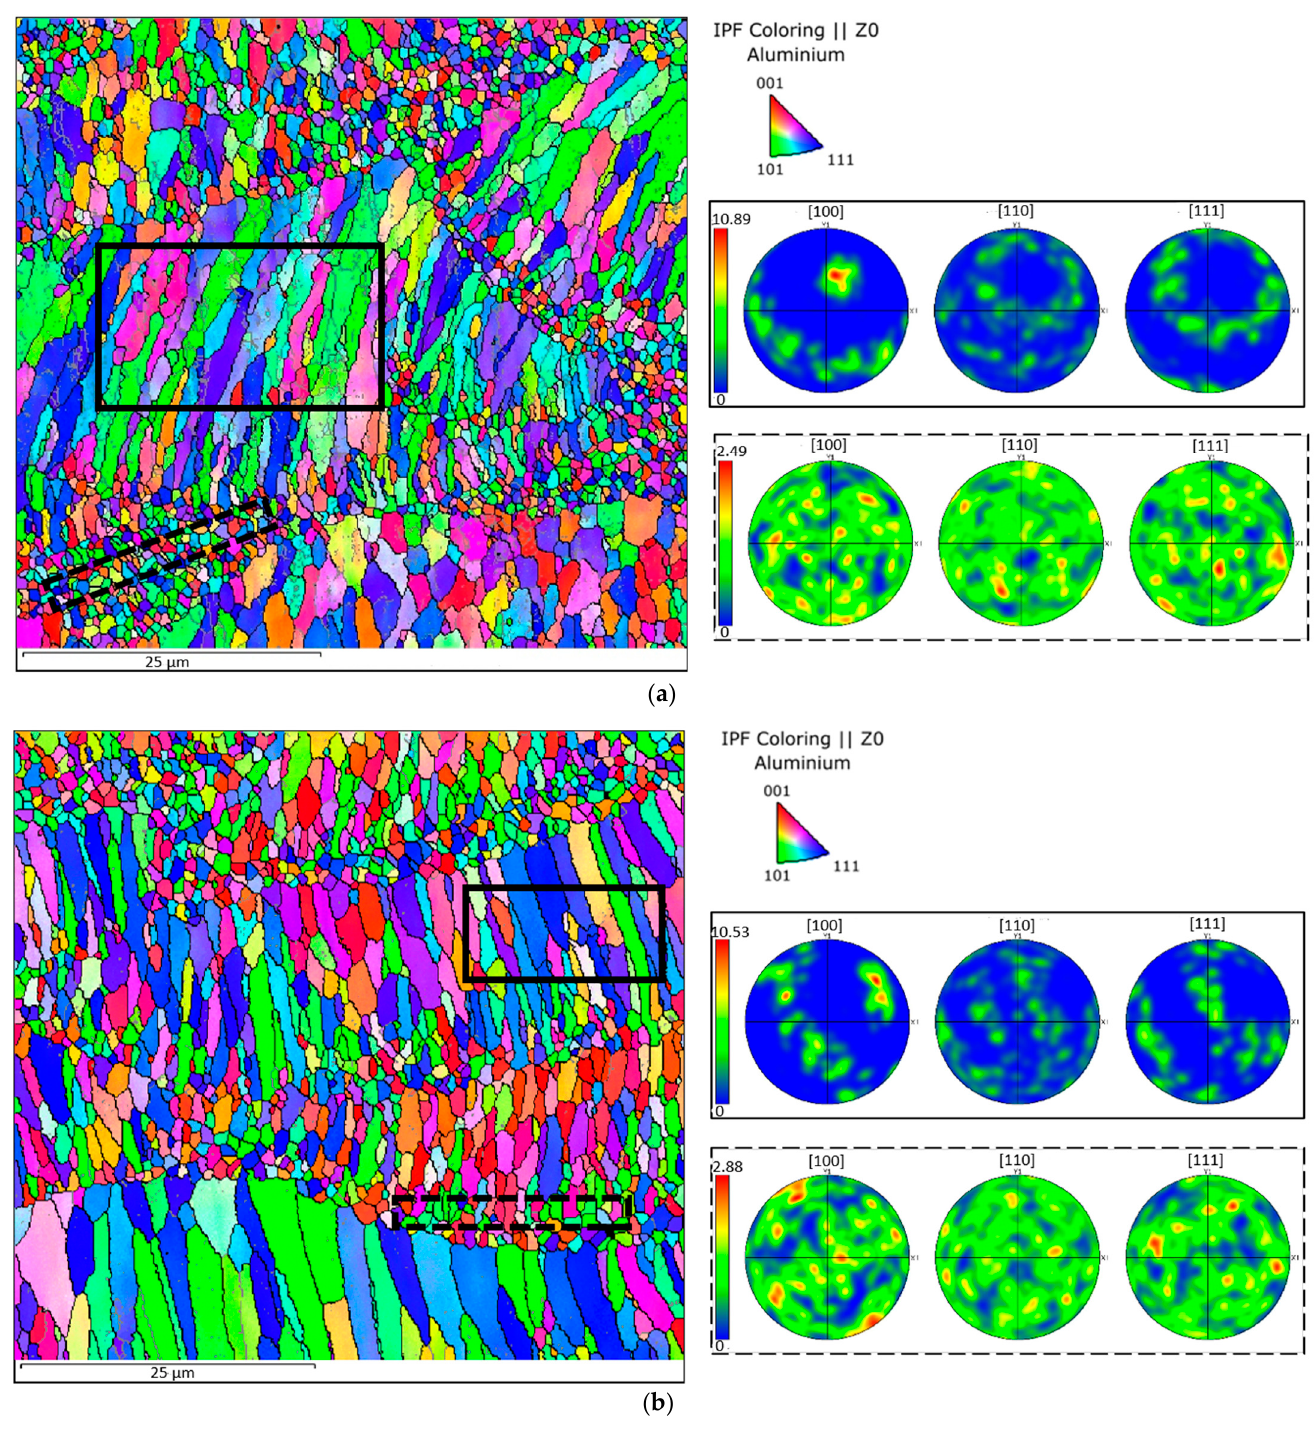
Figure 4. The EBSD orientation maps with pole figures related to CG and FG zones of low-VED ( a ) and high-VED ( b ) as-built samples.